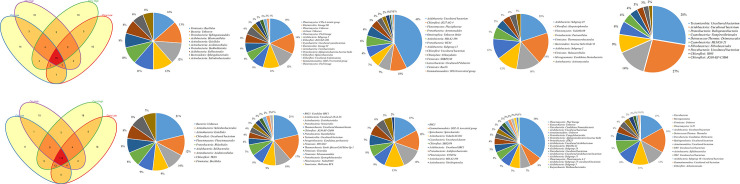
a-f. Shared and unique prokaryotic taxa in 16S rDNA at Chuka. The Venn diagram (3a) show number of shared and unique taxa at order level within farming systems. The pie diagrams (3b - f) show most abundant and unique taxa at order level across farming systems. g-l. Shared and unique prokaryotic taxa in 16S rDNA at Thika. The Venn diagram (3g) show number of shared and unique taxa at order level within farming systems. The pie diagrams (3h - l) show most abundant and unique taxa at order level across farming systems.